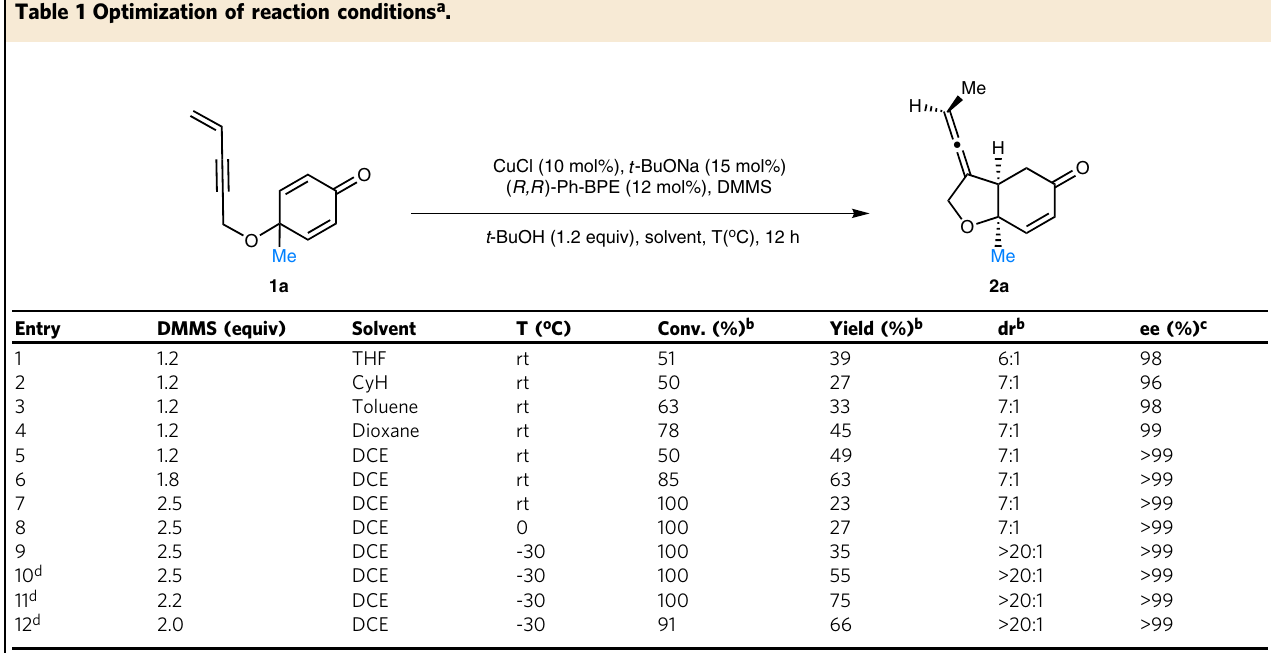
Table 1 Optimization of reaction conditions a